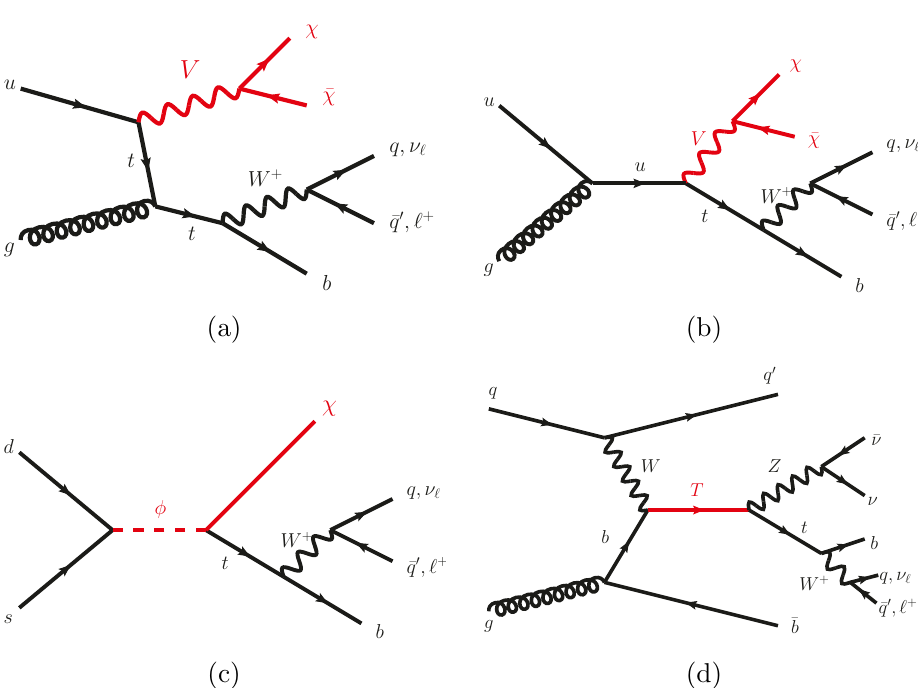
Figure 1 . Representative leading-order diagrams corresponding to the signals sought in this paper: non-resonant (a) t -channel and (b) s -channel production of a top-quark in association with a vector boson V which decays into two DM particles; (c) resonant production of a coloured scalar (cid:30) that decays into a DM particle and a top-quark; and (d) single production of a vector-like T quark decaying into Zt ( (cid:23) (cid:22) (cid:23)bW ). ! massive vector boson V and the t - and u -quarks, and (cid:13) (cid:22) are the Dirac matrices. Another possibility is the resonant case, corresponding to the production of a coloured charge-2/3 scalar ( (cid:30) ) decaying into a top-quark and a spin-1/2 DM particle ( (cid:31) ) [60]. This process, represented in (cid:12)gure 1(c), is described by the following Lagrangian [16,